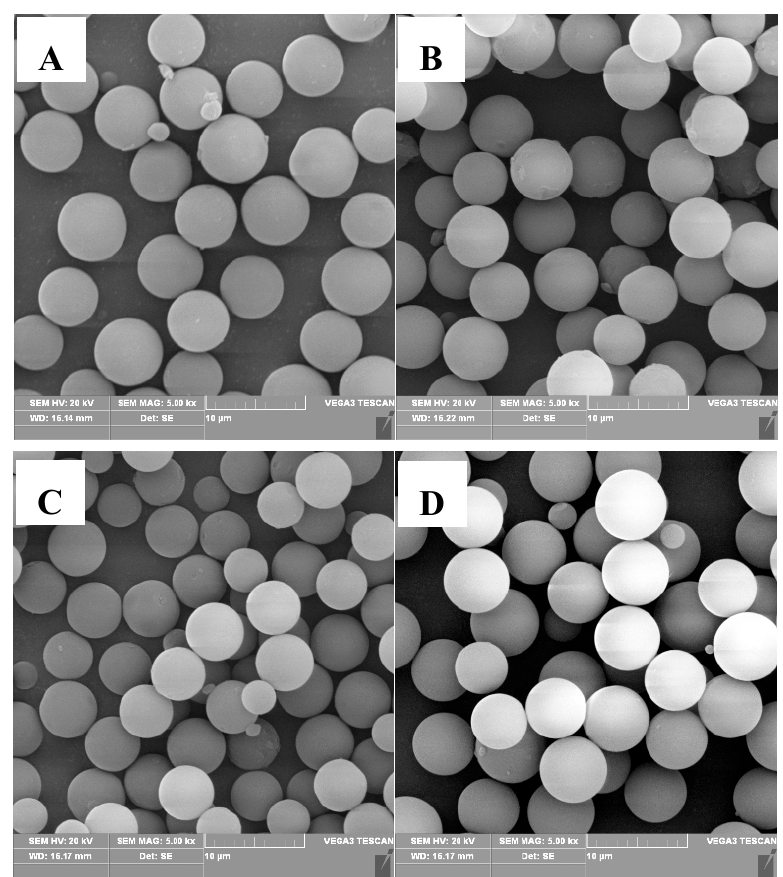
Figure 1. Images of the P(MAA/St) microspheres with different ratios of St:MAA: P-1 ( A ); P-2 ( B ); P-3 ( C ); P-4 ( D ).